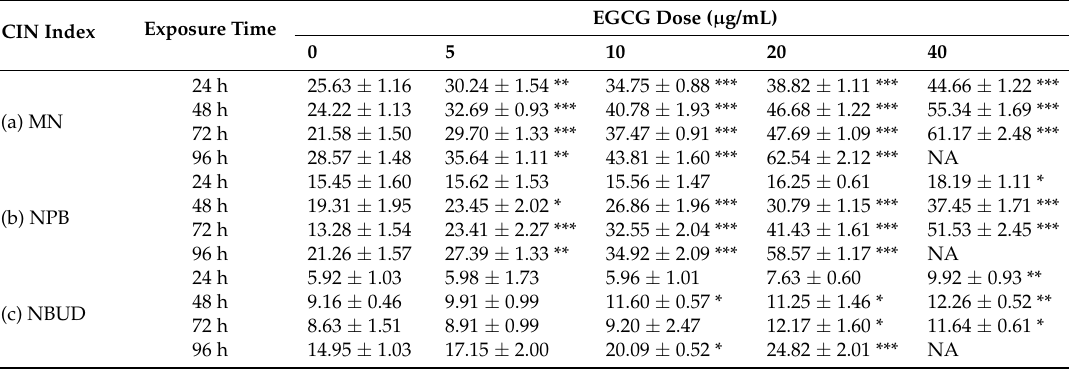
Table 2. The effects of EGCG on frequencies of CIN (MN, NPB, NBUD) in binucleated COLO205 cells.